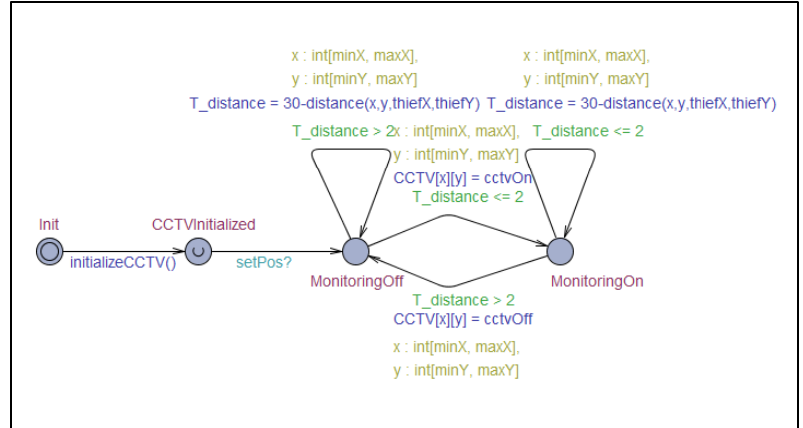
Figure 6. Timed automata for CCTV participating in IoT collaboration for the arrest of a criminal suspect.